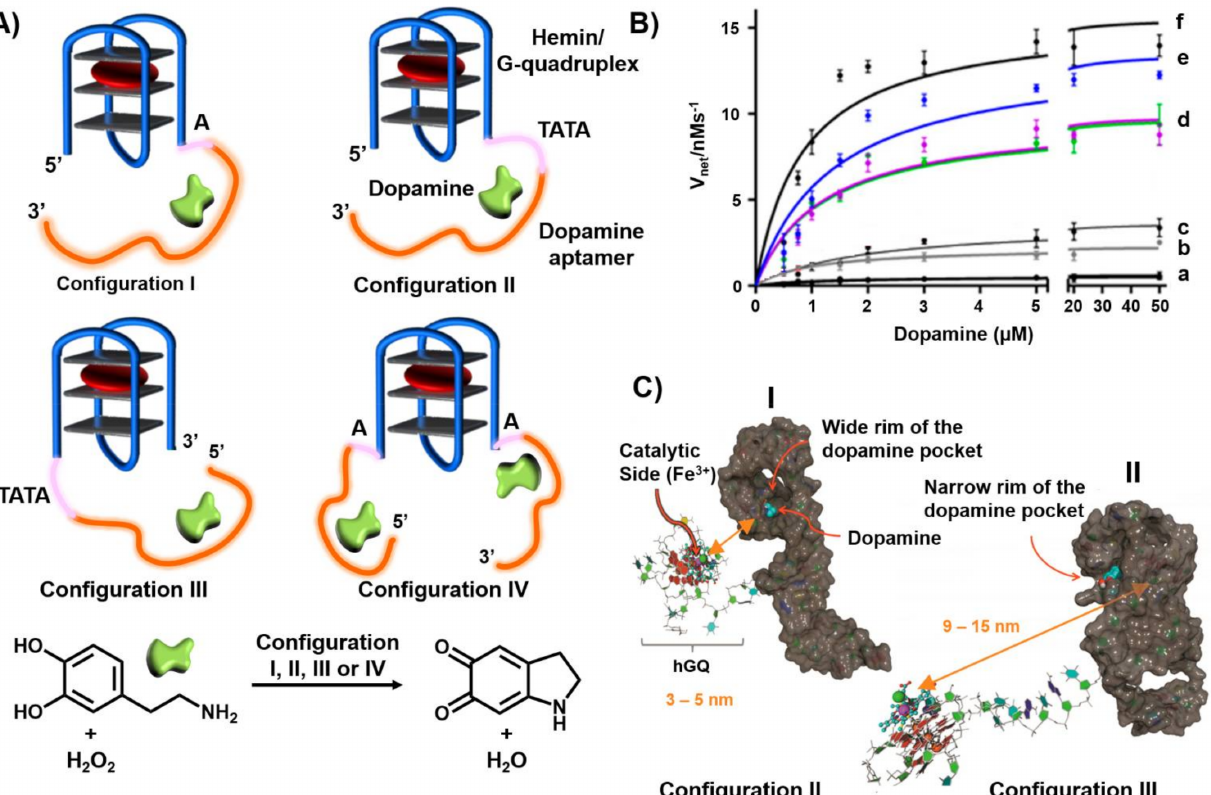
Figure 13. ( A ) Hemin/G-quadruplex-dopamine aptamer nucleoapzyme structures where in Configuration I the catalyst is linked to the 5 (cid:48) -end of the aptamer through a single A-bridge. In configuration II the catalyst is linked to the 5 (cid:48) -end of the aptamer through a TATA tether. In configuration III the catalyst is linked to the 3 (cid:48) -end of the aptamer through a TATA tether. In configuration IV the catalyst is linked to the 3 (cid:48) and 5 (cid:48) -ends of the aptamer through a single A-bridge. The reaction driven by the systems correspond to the hemin/G-quadruplex catalyzed oxidation of dopamine by H 2 O 2 to aminodopachrome. ( B ) Rates of oxidation of dopamine by H 2 O 2 at different concentrations of dopamine: a = separated Hemin/G-quadruplex and dopamine aptamer; b = nucleoapzyme configuration III; c = scrambled sequence; d = nucleoapzyme configuration I; e = nucleoapzyme configuration II; f = nucleoapzyme configuration IV ( C ) Molecular dynamics energy minimized structures of: (I) nucleoapzyme in configuration II; (II) nucleoapzyme in configuration III. Reproduced with permission from ref. [172]. Copyright 2016 American Chemical